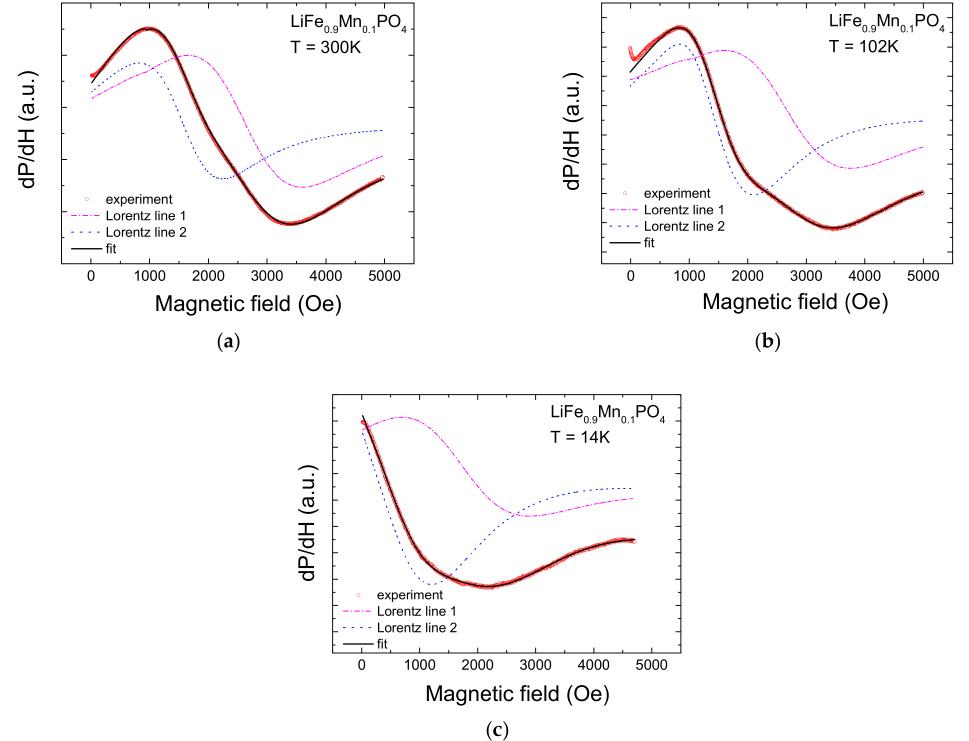
Figure 5. Decomposition of the ESR spectra of LiFe 0.9 Mn 0.1 PO 4 at different temperatures: ( a ) T = 300 K, ( b ) T = 102 K, and ( c ) T = 14